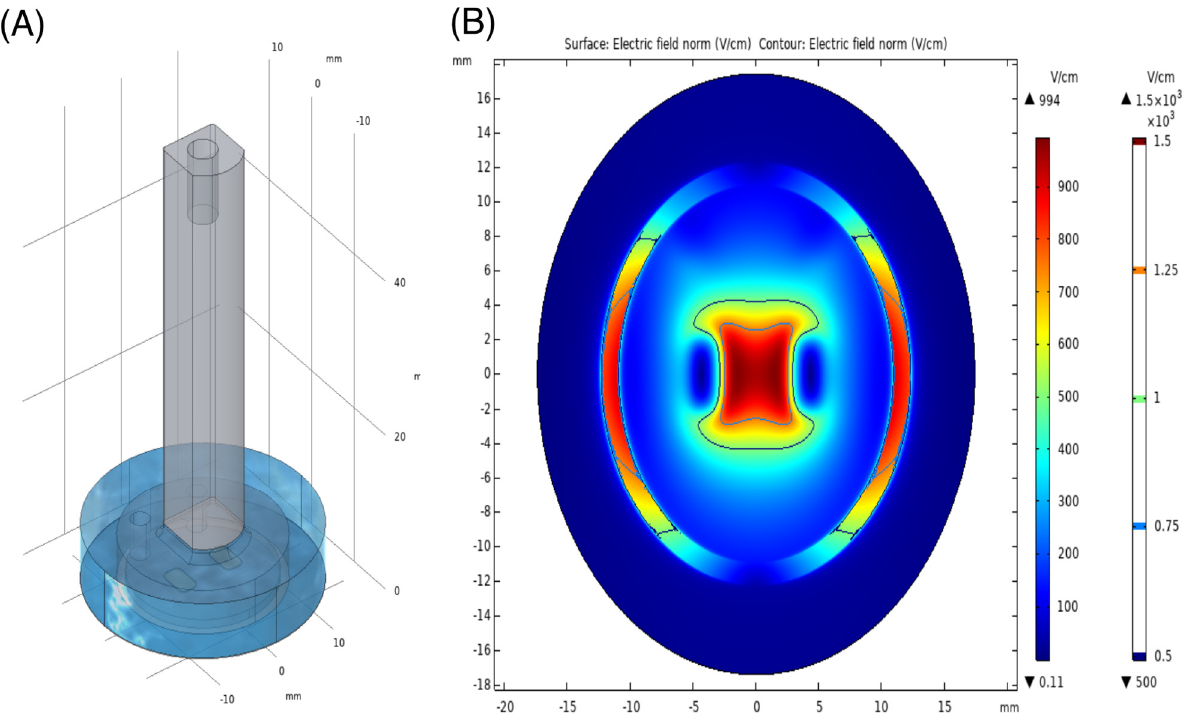
Figure 6. The numerical model ( A ) and the electric field strength plot ( B ) of the 2D electroporation at half the cell layer thickness of 50 μ m.